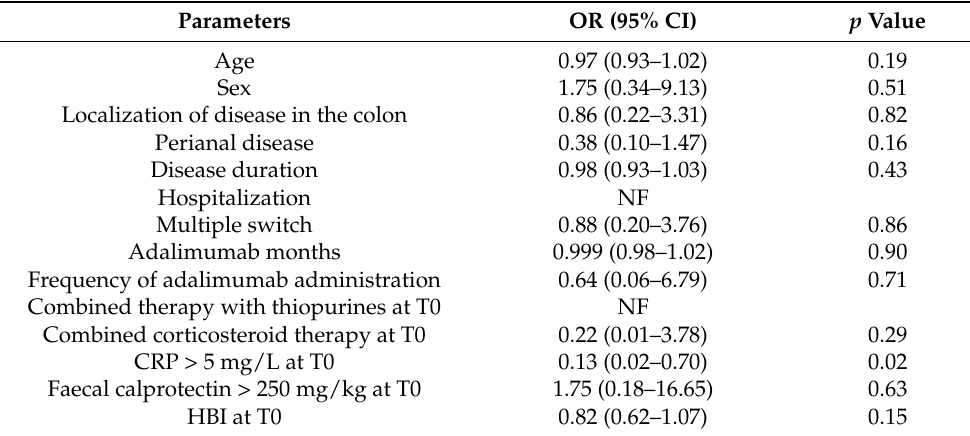
Table 2. Predictors of success of the switch at univariate